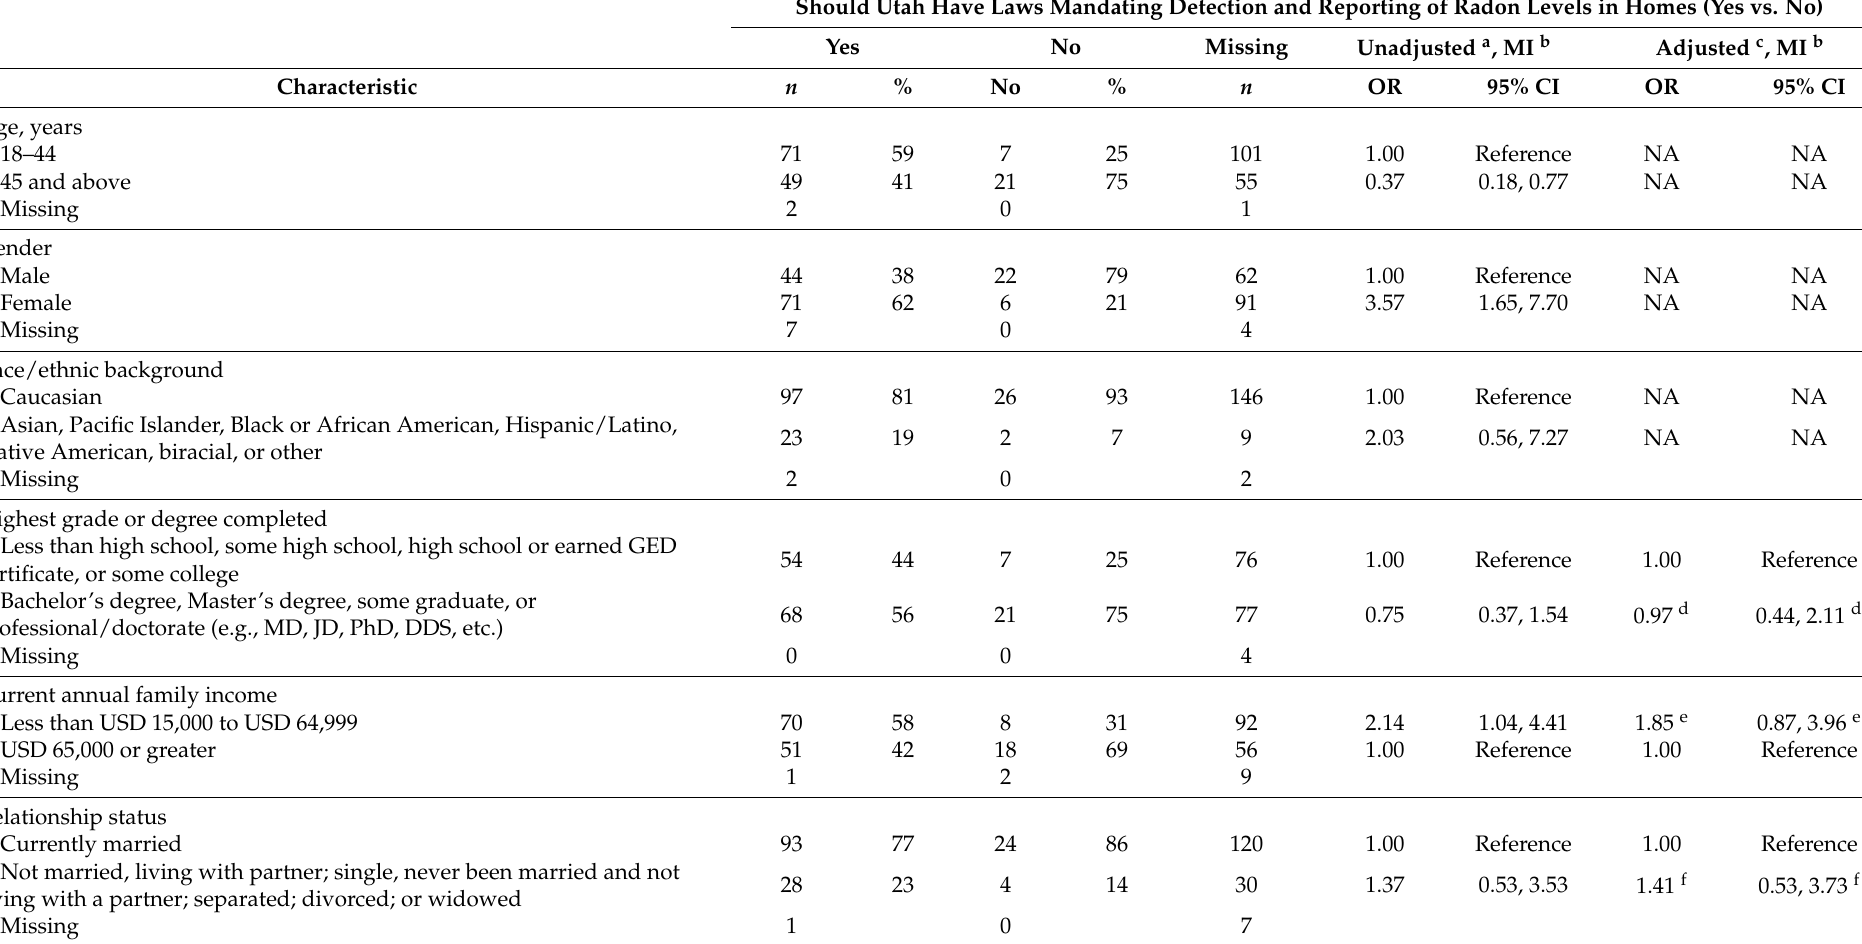
Table 3. Unadjusted and adjusted, multiply imputed associations between characteristics and opinions regarding whether Utah should have laws mandating detection and reporting of radon levels in homes among radon testing survey participants, Utah County, Utah, May 2014–January 2016. Should Utah Have Laws Mandating Detection and Reporting of Radon Levels in Homes (Yes vs.